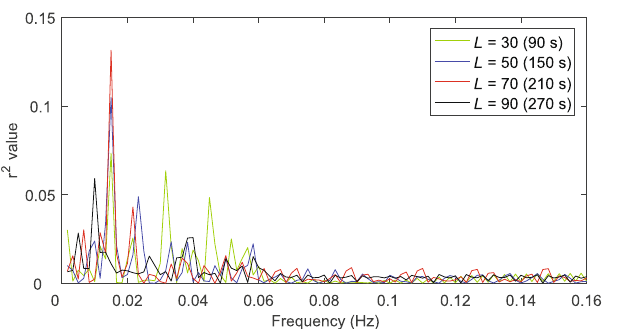
Figure 2. Separability ( r 2 value) between NC and eMCI for different frequency dynamic FC spectrum. The FC is measured for the discriminative link connecting the left inferior frontal gyrus and the left angular gyrus. Results from the use of various window lengths are